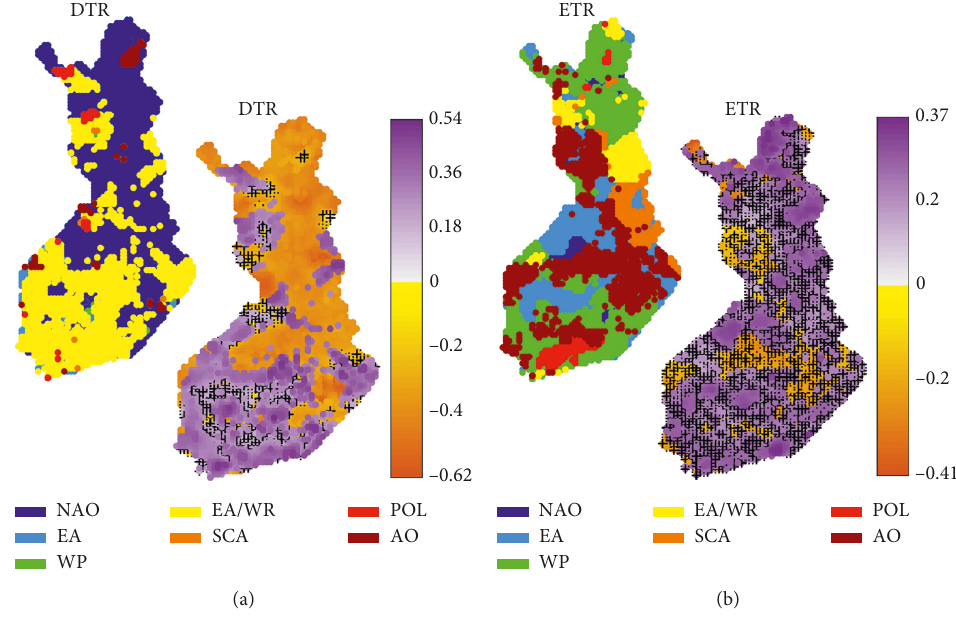
Figure 11: Spatial distribution maps of most influential NHTP (left) and its corresponding Spearman rank correlation (right) for (a) DTR and (b) ETR in Finland during 1961–2011. The stippling indicates areas where the correlations are statistically insignificant ( p